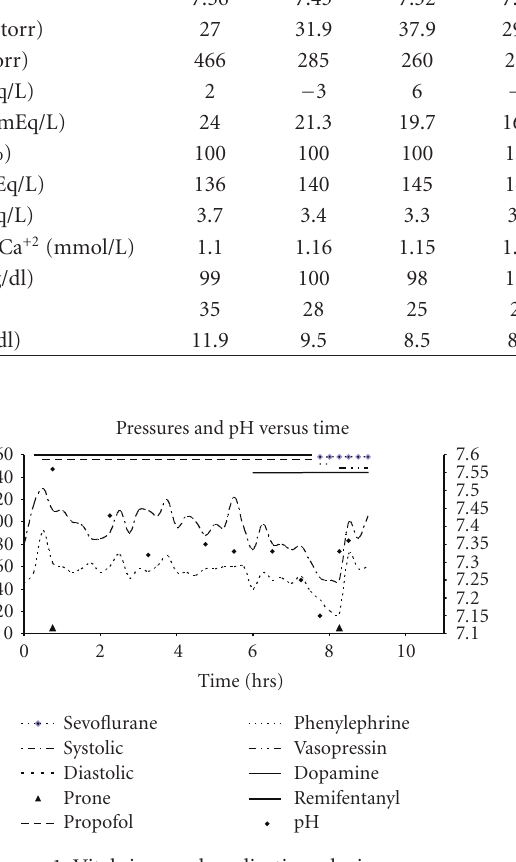
at 5 mcg kg − 1 min − 1 . Bicarbonate 100 mEq and